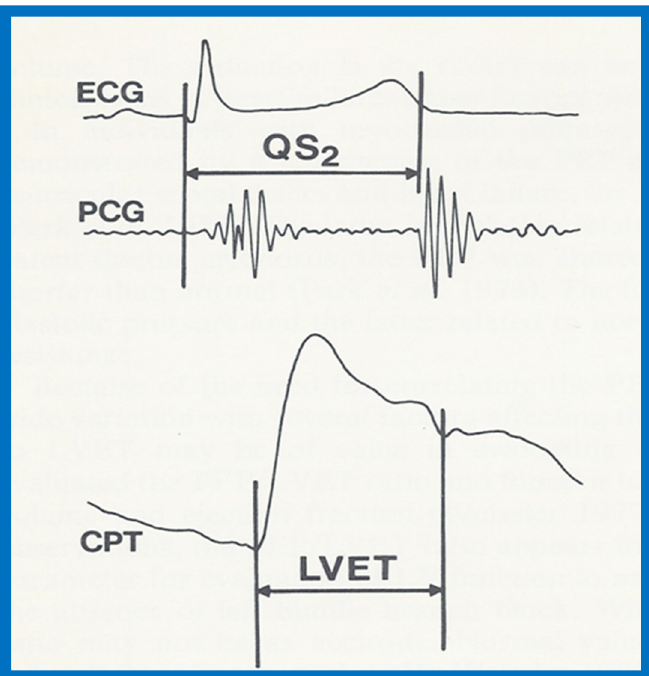
Figure 11. Simultaneous recording of the electrocardiogram (ECG), phonocardiogram (PCG) and carotid pulse trace (CPT) to illustrate measurement of left ventricular ejection time (LVET) and Q wave of the ECG to S 2 (QS 2 ). The preejection period (PEP) is calculated by subtracting LVET from QS2. Reproduced from Rao P.S. [6].